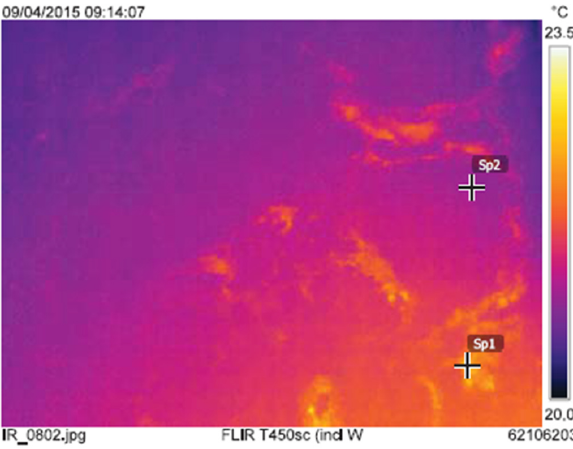
Figure 8. Internal wall, North ‐ East oriented.